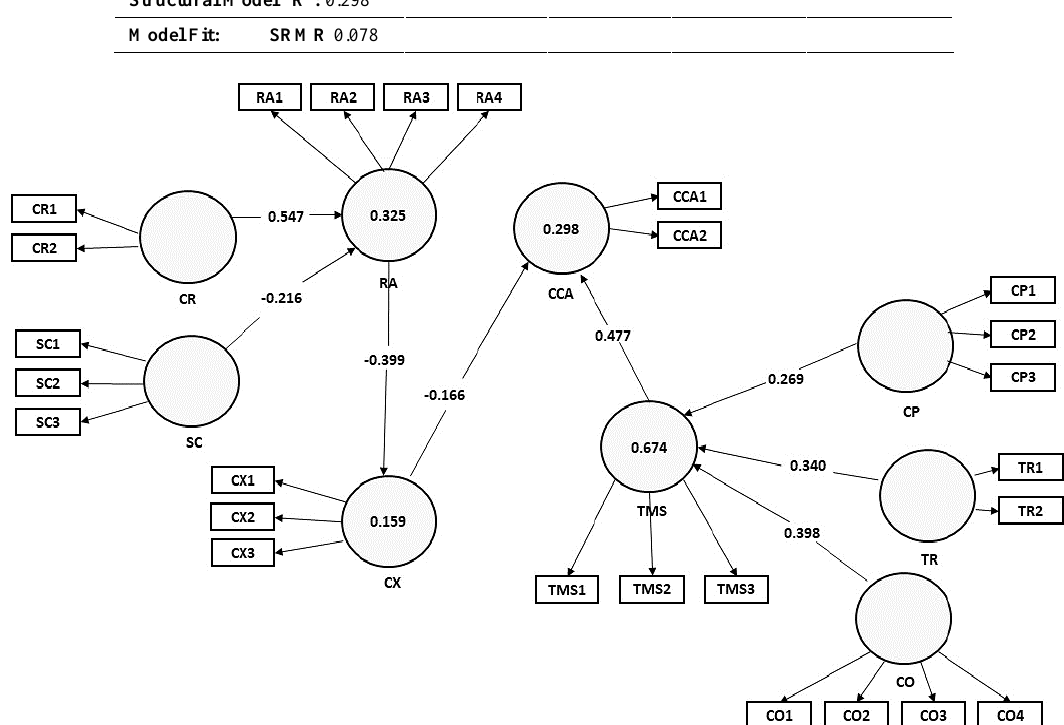
Figure 3. The path diagram of the proposed